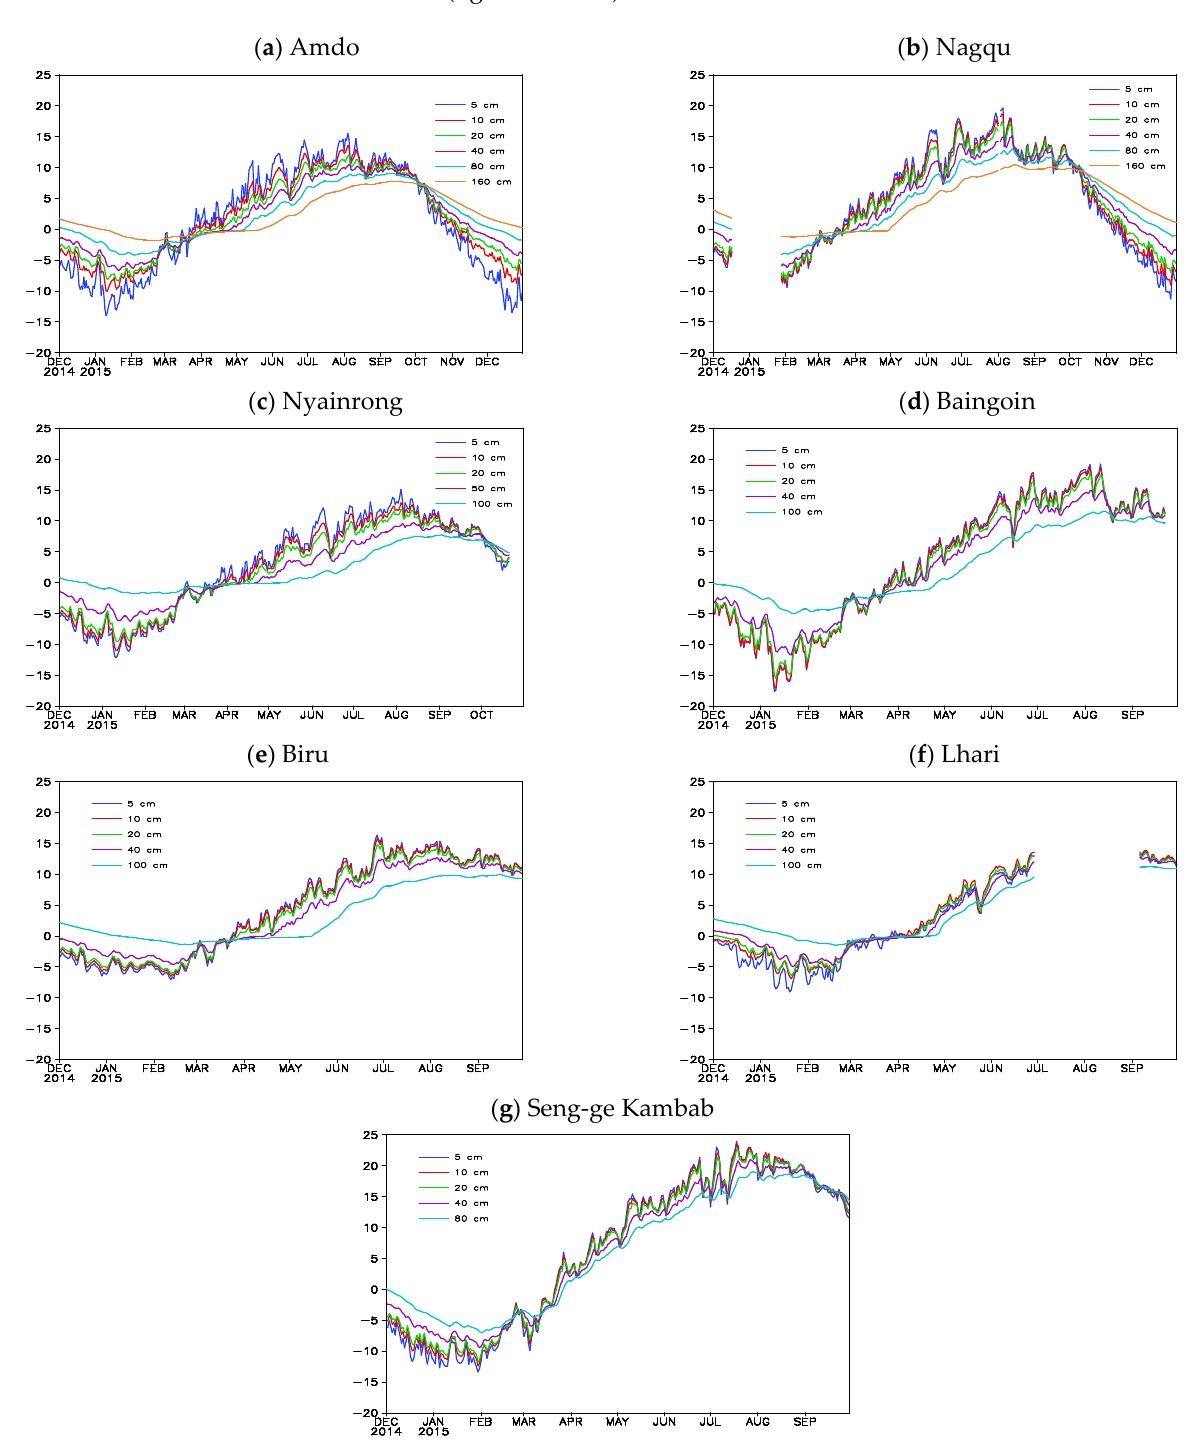
Figure 5. Time series of daily mean soil temperature at different depths (unit: °C). The seasonal variation trend of the soil temperature at different depths at the seven stations was quite consistent. Seng-ge Kambab station had the largest seasonal variation, and Biru station had the smallest. The soil temperature reached the lowest in mid-January, and the temperature from low to high was Baingoin, Amdo, Seng-ge Kambab, Nyainrong, Lhari and Biru. In summer, the soil temperature from high to low was Seng-ge Kambab, Nagqu, Baingoin, Biru, Lhari, Amdo and Nyainrong. During the freezing period, the soil temperature increased with depth, while the soil temperature in